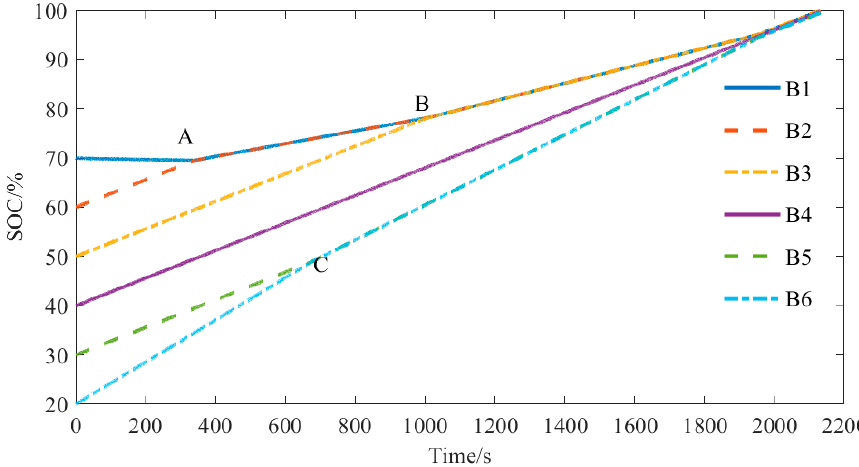
Figure 14. Equalization process in charging